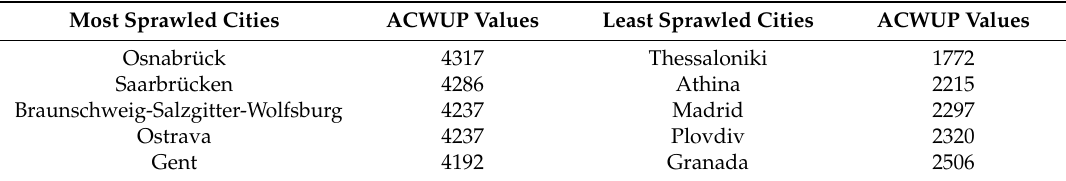
Table 2. Most and least sprawled cities with a population above 500 thousand inhabitants, classified based on their ACWUP